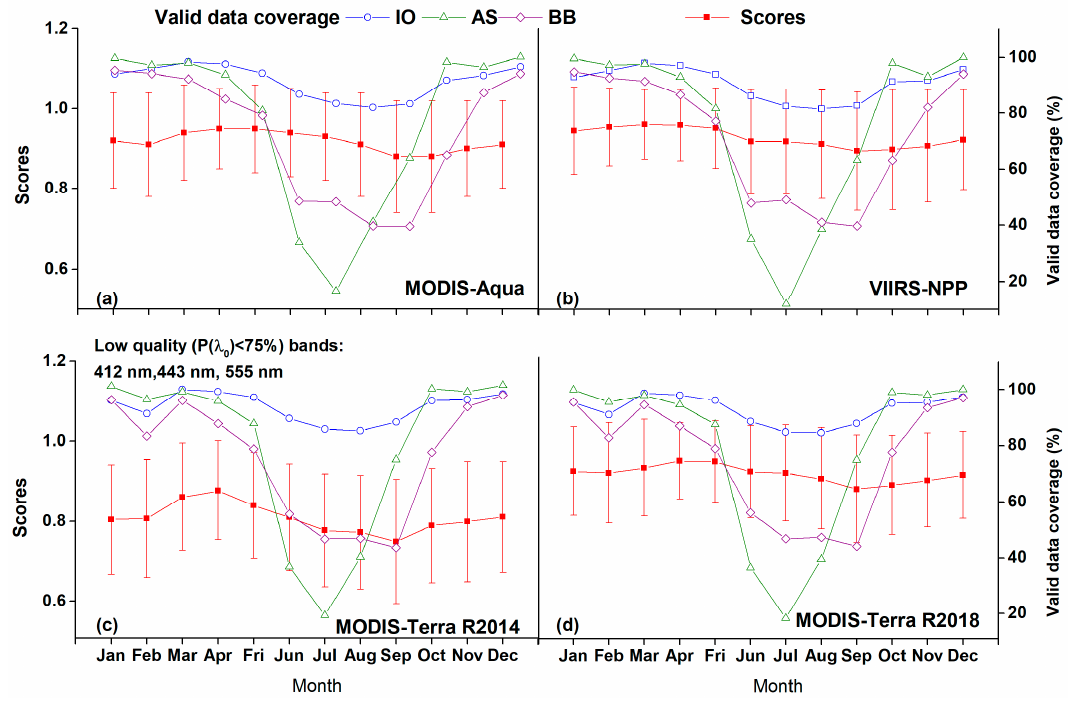
Figure 4. Monthly averaged scores (left y –axis, red squares) of MODIS–Aqua ( a ), VIIRS–NPP ( b ) and MODIS–Terra ( c , d ) level 3 R rs ( λ ) products over the IO in 2016. The valid data coverage (open symbols, right y –axis) is overlaid. The low–quality bands (P( λ i ) < 75%) for each satellite dataset (if any) are also shown.